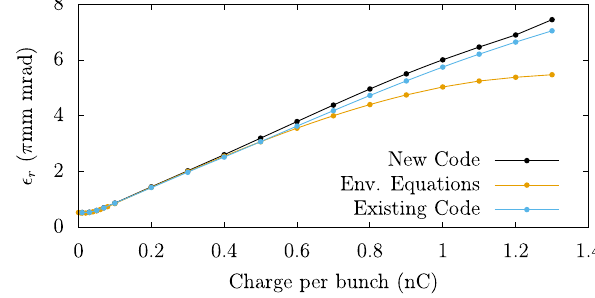
FIG. 9. Dependence of emittance on charge per bunch.